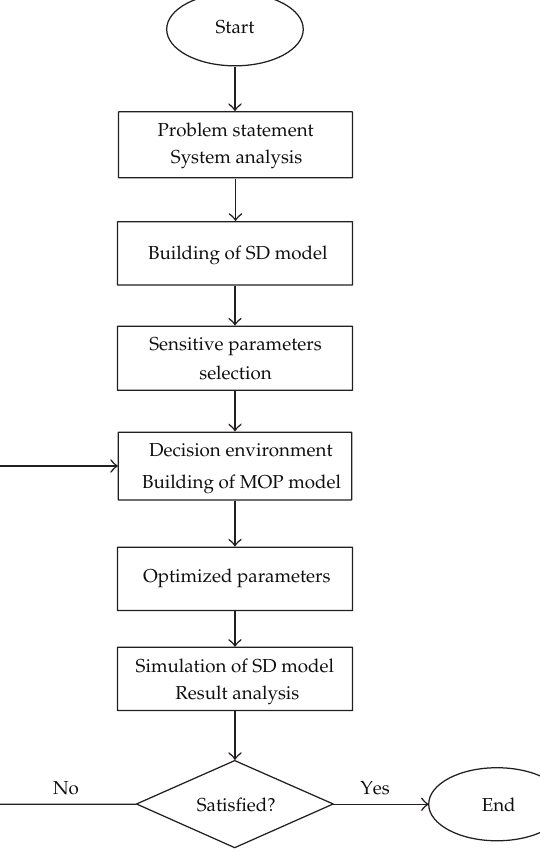
Figure 2: The general framework of the modeling